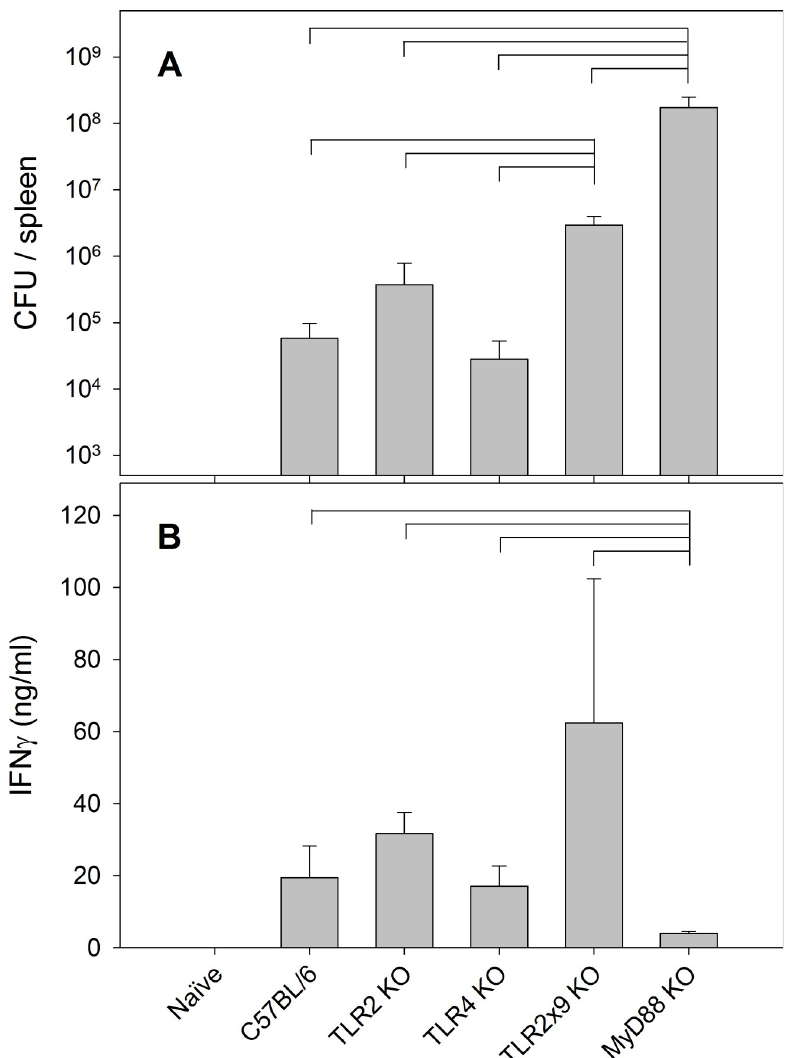
Fig 7. IFN- γ production by splenocytes from Ft LVS-infected mice depends on MyD88 but not TLRs 2, 4, or 9. C57BL/6 and the indicated KO mice were infected with 10 5 LVS i.d. After four days, mice were sacrificed, spleens were disrupted, and appropriate dilutions were plated on MH plates for bacterial counts (A). Values shown are the mean number of CFU/spleen ± SD of viable bacteria from three independent experiments. From the same groups, splenocytes were prepared and cultured in vitro for three days, and supernatants were then collected and analyzed for IFN- γ production by ELISA (B). Values shown are the mean concentration ± SD of from two independent experiments. Brackets indicate significant differences between each pair of bracketed groups ( P <